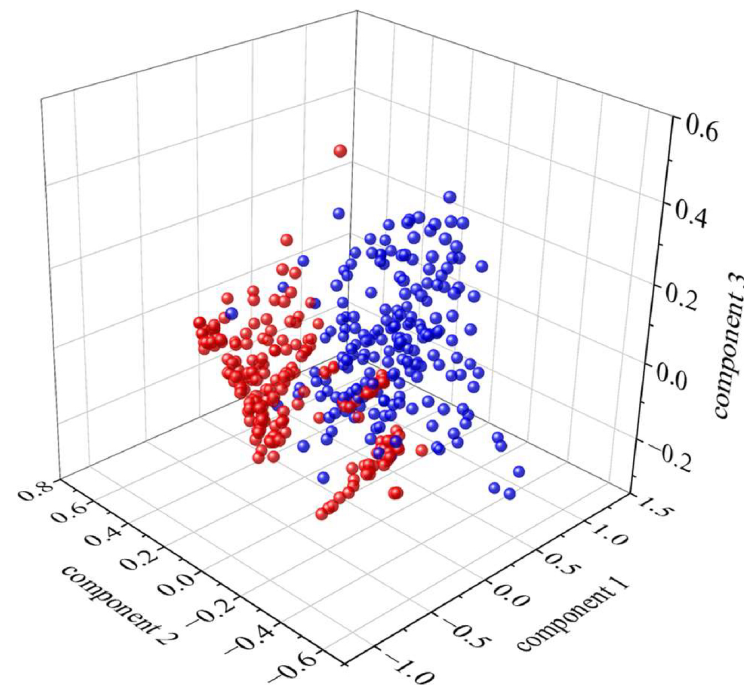
Figure 12. Visualization of data (red: normal, blue: